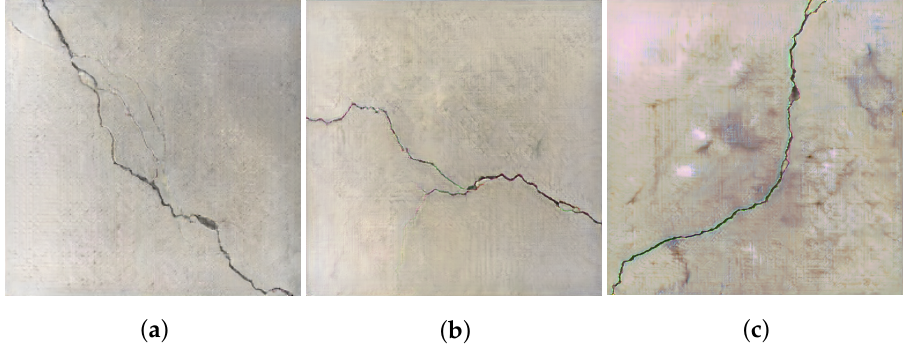
Figure 8. Sample images generated by ProGAN at ( a ) 256 × 256, ( b ) 512 × 512, and ( c ) 1024 × 1024 resolutions. Note: The images in this figure are down-sized to the same dimensions for better